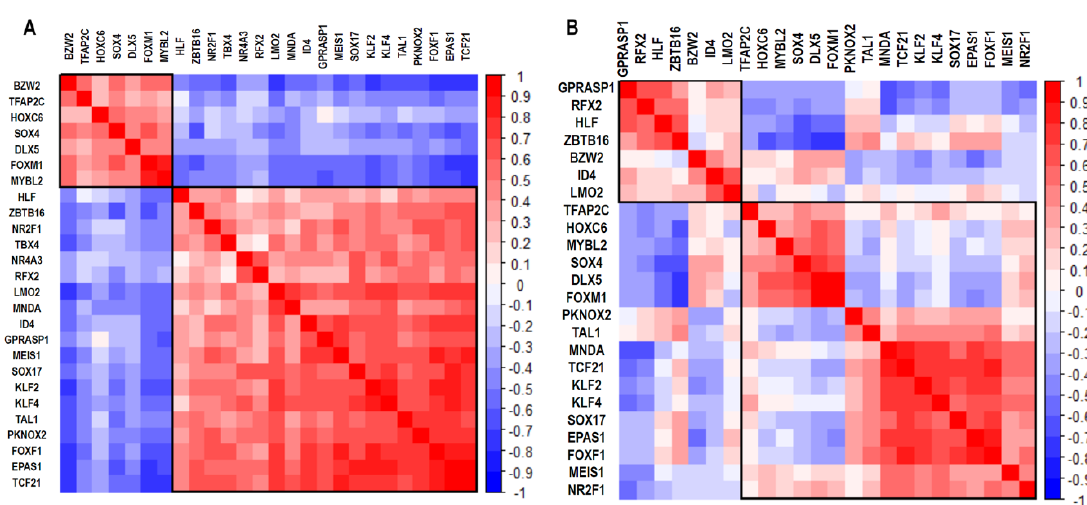
Figure 2. Correloplot of the mRNA expression correlation of the most frequently dysregulated transcription factors in every lung cancer type: ( A) NSCLC and ( B) SCLC. In blue are the negatively correlated TFs, and in red are the positively correlated TFs. Table 3. Common connection patterns (CCPs) of lung cancer (LC) (microarrays (MA) and RNA-Seq (RNAS)) and pulmonary arterial hypertension (PAH), iRegulon main regulators (FOXM1 and MYBL2), number of targets, number of binding motifs (BM), and normalized enrichment score of the motifs (NES).